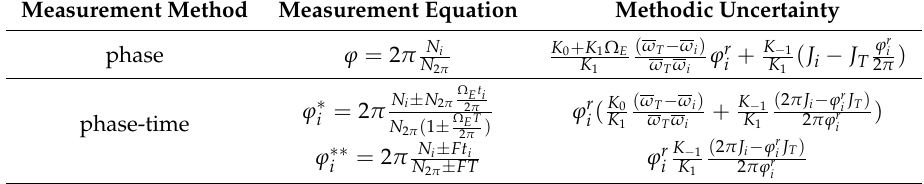
Table 1. Here ω i —average rotation rate of the ring laser (RL) during measurement t i ; ϕ r of RL rotation during measurement t i . T is the full revolution time of the RL in the laboratory reference system; ω T —average rotation rate of the RL during the full revolution; J i = the “+” or “ ” sign is determined by the rotation direction of the RL—the “+” sign for CW and the “ − sign for the